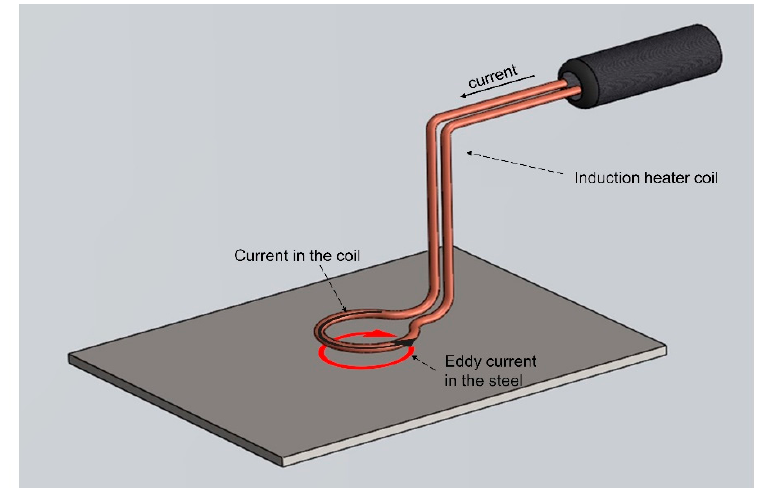
Figure 1. The under-test steel and the induction coil set up.